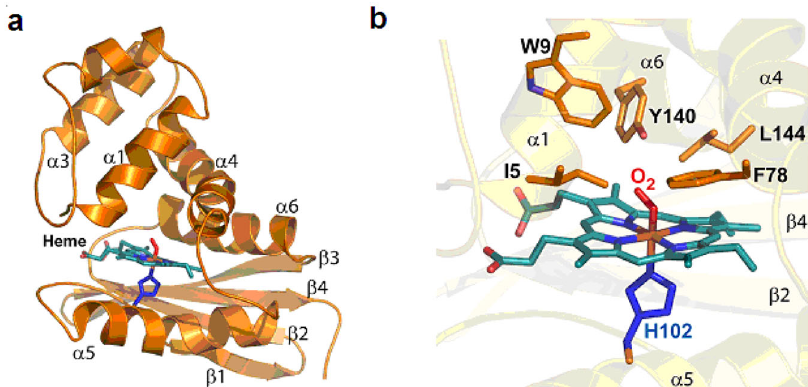
Fig. 1 Heme distortion revealed by X-ray crystal structure. a Overall 3D structure of the Ct H-NOX sensor. The heme prosthetic group is in cyan, the proximal histidine (His102) coordinating the iron in blue and the molecular oxygen in red. The fi gure was generated using Pymol; PDB ID: 1XBN. b Zoom into the heme environment and the distal amino acids surrounding the dioxygen